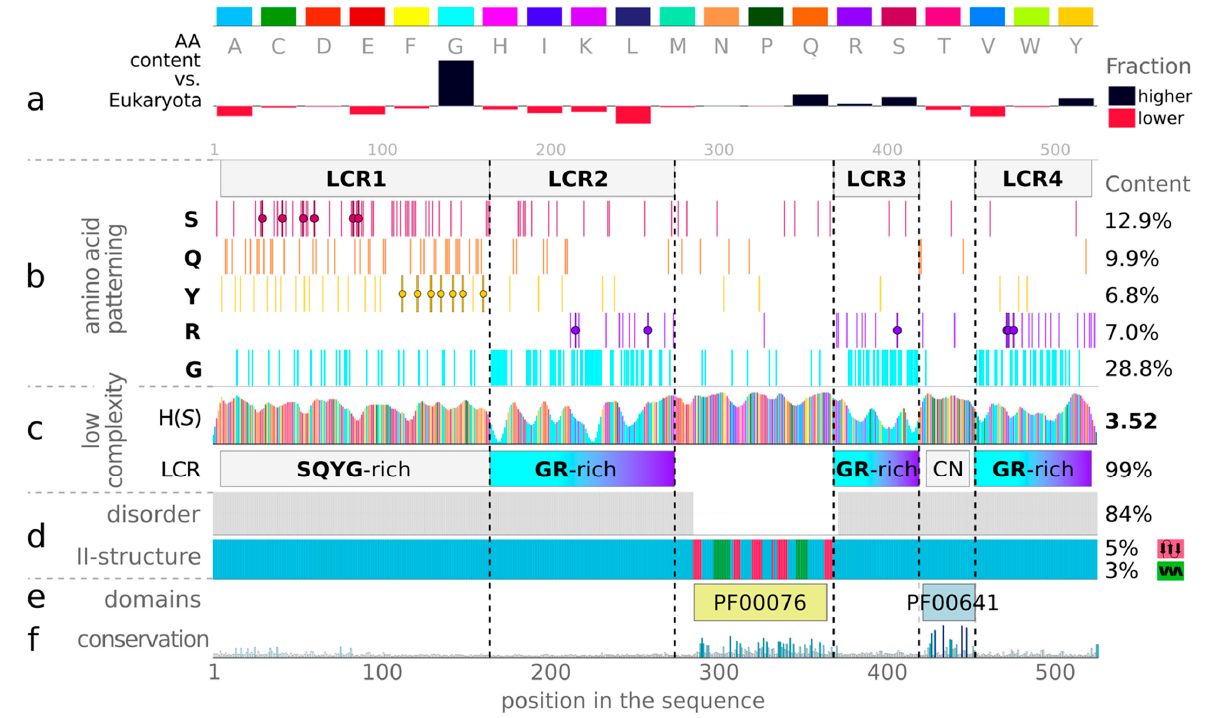
Figure 4. Sequence composition and complexity of FUS. The upper panel ( a ) shows the amino acid (AA) content of the query sequence compared to the Eukaryota dataset (black indicates higher and red the lower content than the reference). The bottom panel shows, the following information for a specific query sequence: ( b ) the patterning of enriched amino acids (S (magenta), Q (orange), Y (yellow), R (purple), G (cyan)); ( c ) low-complexity measures (a color scale corresponding to each amino acid) provided as regions of particular AA enrichments (LCR row), and the sequence information content (H(S) row, Shannon entropy); ( d ) consensus of predicted disorder regions (gray) and secondary-structure assignment (helix in green, strand in magenta, coil in light blue); ( e ) detected Pfam domains; and ( f ) evolutionary conservation derived from the multiple sequence alignment against UniRef50 (blue shades). The amino acid patterning section contains points corresponding to the locations of the most relevant serine phosphorylation sites (residues 30, 42, 54, 61, 84, 87) [37], arginine methylations (residues 216, 259, 407, 472, 473, 476) [44], and tyrosine mutations (residues 113, 122, 130, 136, 143, 149, 161)